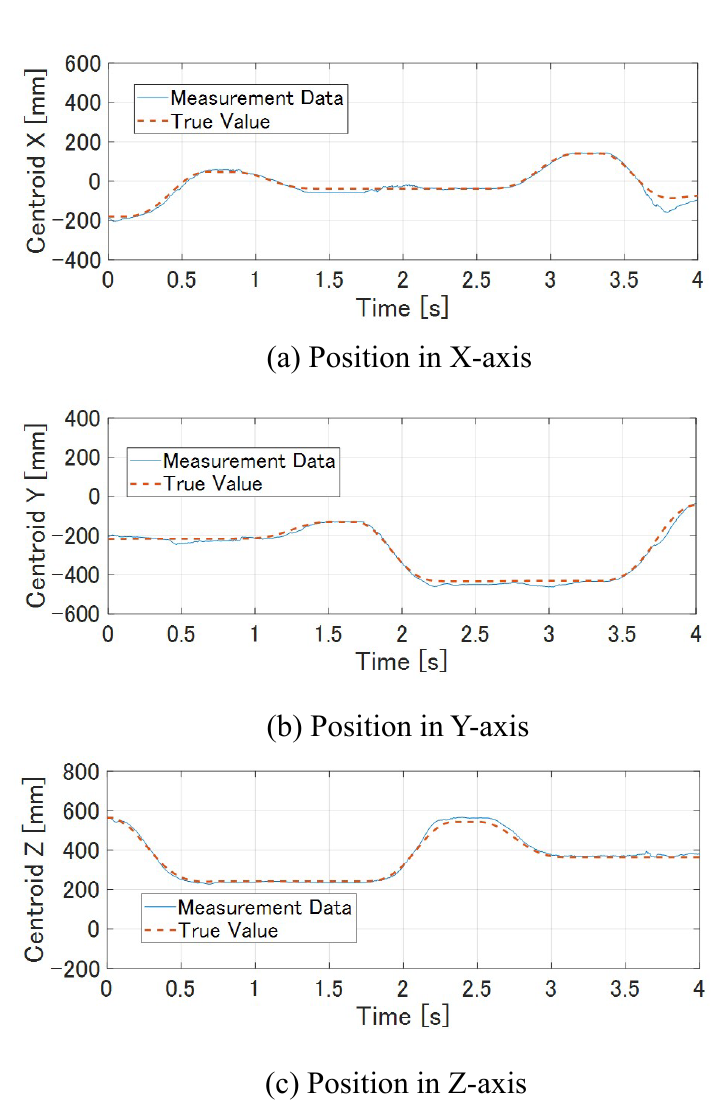
Figure 20. Centroid of cylinder.